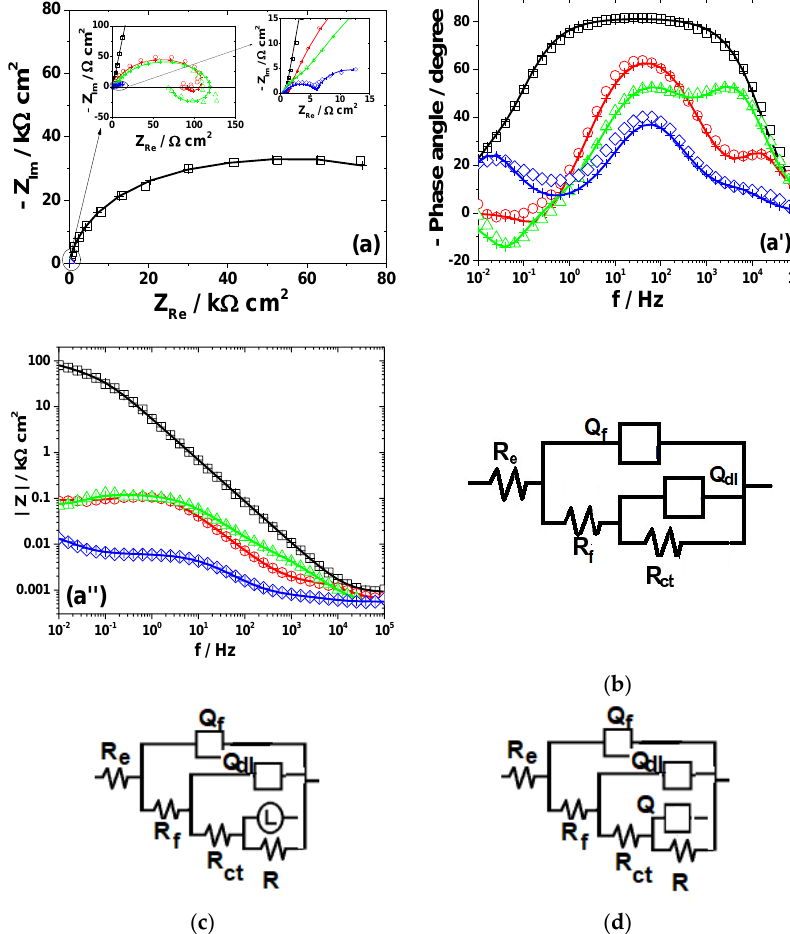
Figure 5. EIS results of Sn after immersion in different bromide-based electrolytes: Nyquist diagrams ( a ); Bode plot of | Z | vs. frequency ( a’ ); and Bode plot of phase angle vs. frequency ( a” ). The equivalent electrical circuits used for EIS fitting ( b – d ). Symbols represent the experimental data and lines with cross (— + —) correspond to the simulated spectra. Electrolytes: ( (cid:3) ) Sol. A; (O) Sol. B; ( ♦ ) Sol. C; and ( ∆ ) Sol.